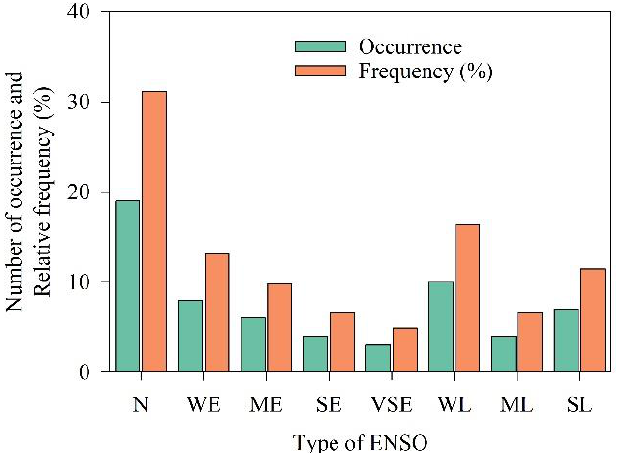
Figure 5. The occurrence of ENSO intensities in NEB capitals from 1960 to 2020. Note: Neutral (N), weak El Niño (WE), moderate El Niño (ME), strong El Niño (SE), very strong El Niño (VSE), weak La Niña (WL), moderate La Niña (ML), and strong La Niña (SL).